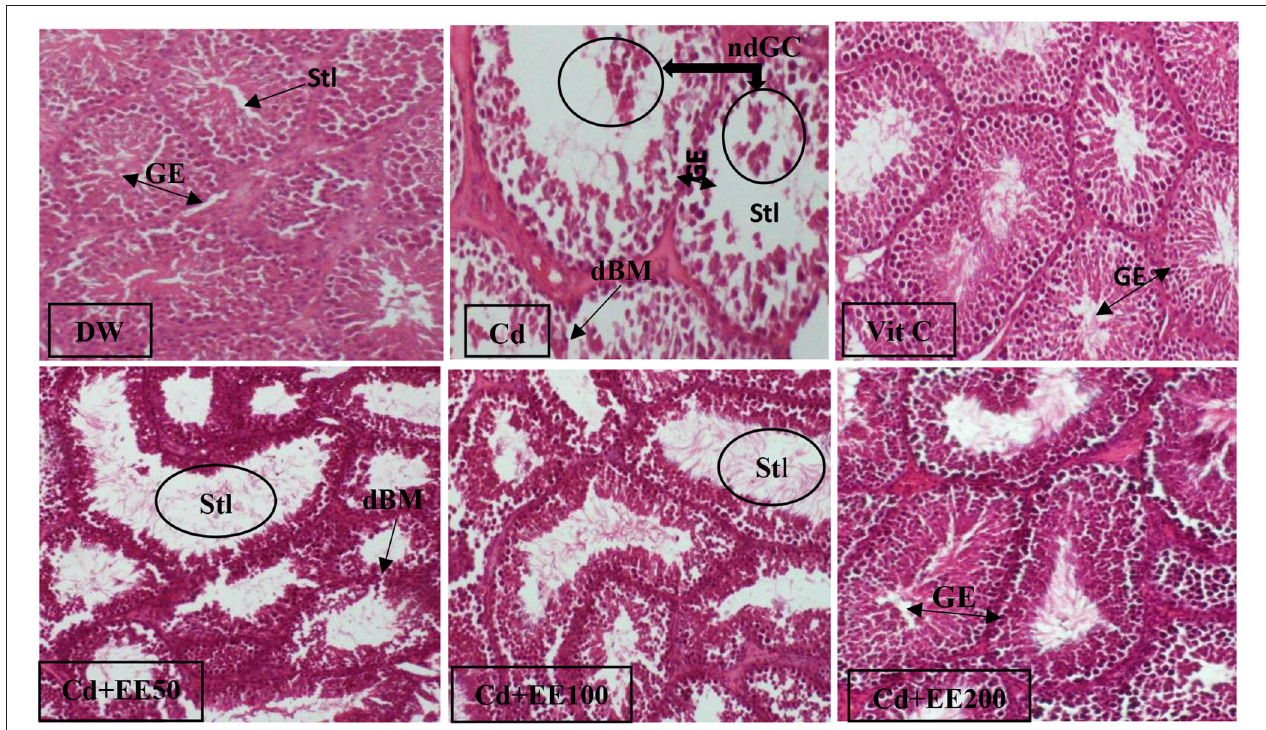
FIGURE 3 | Histological sections of testes in guinea pigs exposed to cadmium chloride and treated with EEPLM leaves (HE × 400). dBM, degraded basal membrane; ndGC, non differentiated germinal cells; Stl, seminiferous tubule lumen; GE, germinal epithelium. DW, neutral control (distilled water); Cd, negative control (26.25mg of